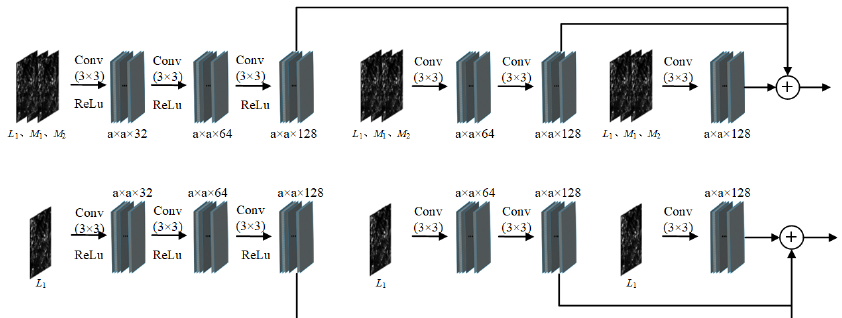
Figure 3. Multiscale feature-fusion